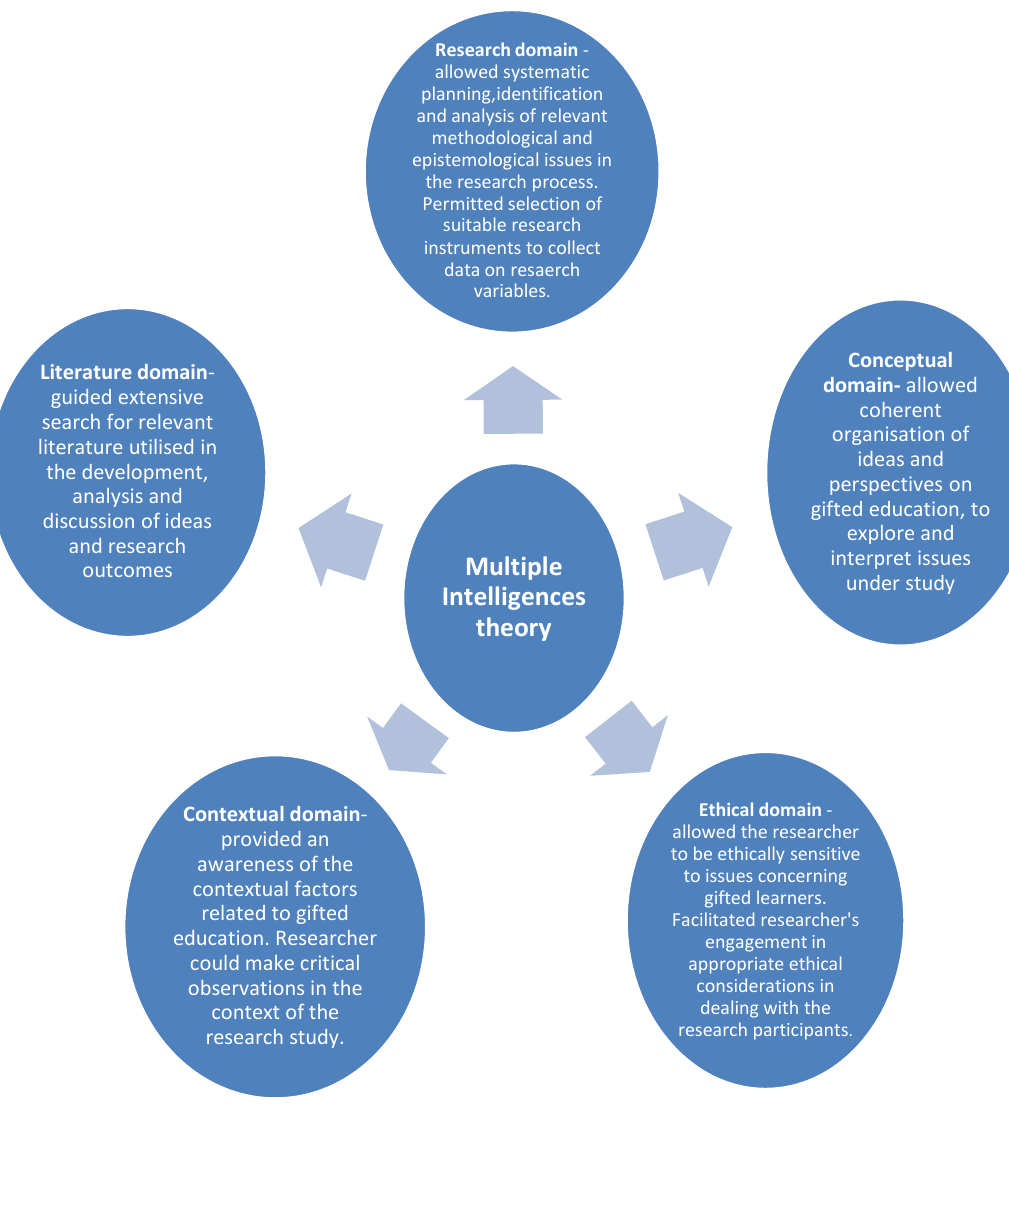
Figure 2.2: Summary of the MI Theory